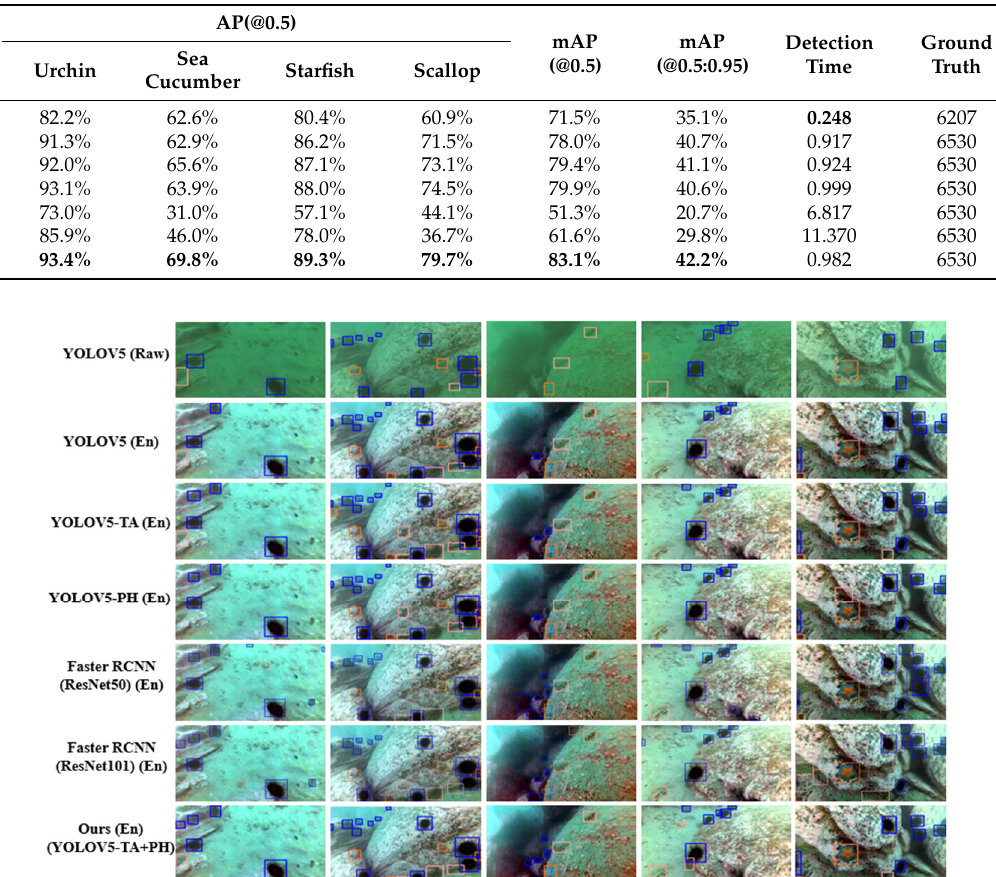
Table 4. Overall identification performance evaluation.